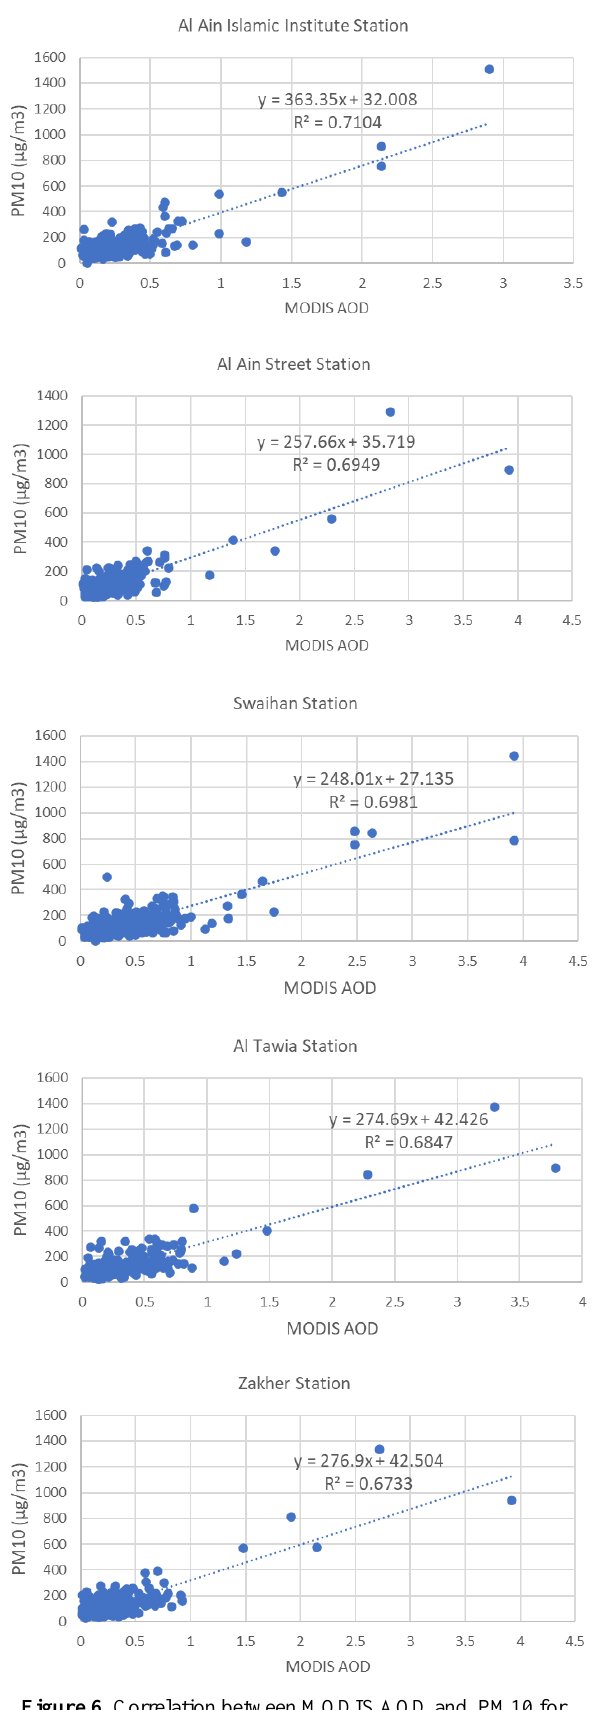
Figure 6 . Correlation between MODIS AOD and PM10 for individual air quality monitoring stations.